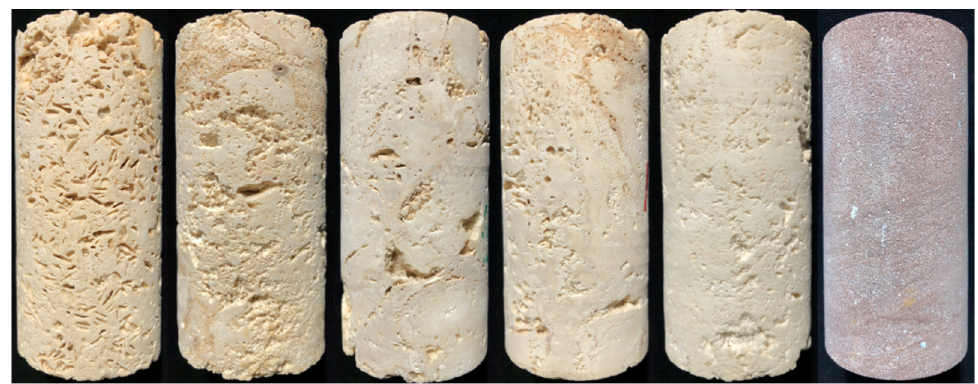
Figure 2. Standard cylinder specimens, from left to right are carbonate A, B, C, D, E and sandstone S. Table 1. Sample size. Rock